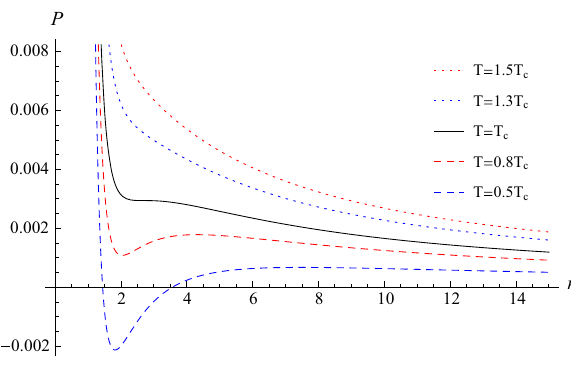
Fig. 2 P − r h diagram of NED AdS black holes the ideal gas. The critical isotherm T = T c is denoted by the solid black line and the lower solid dashed lines correspond to temperatures lower than T c . The P − V diagram is like the Van der Waals gas.